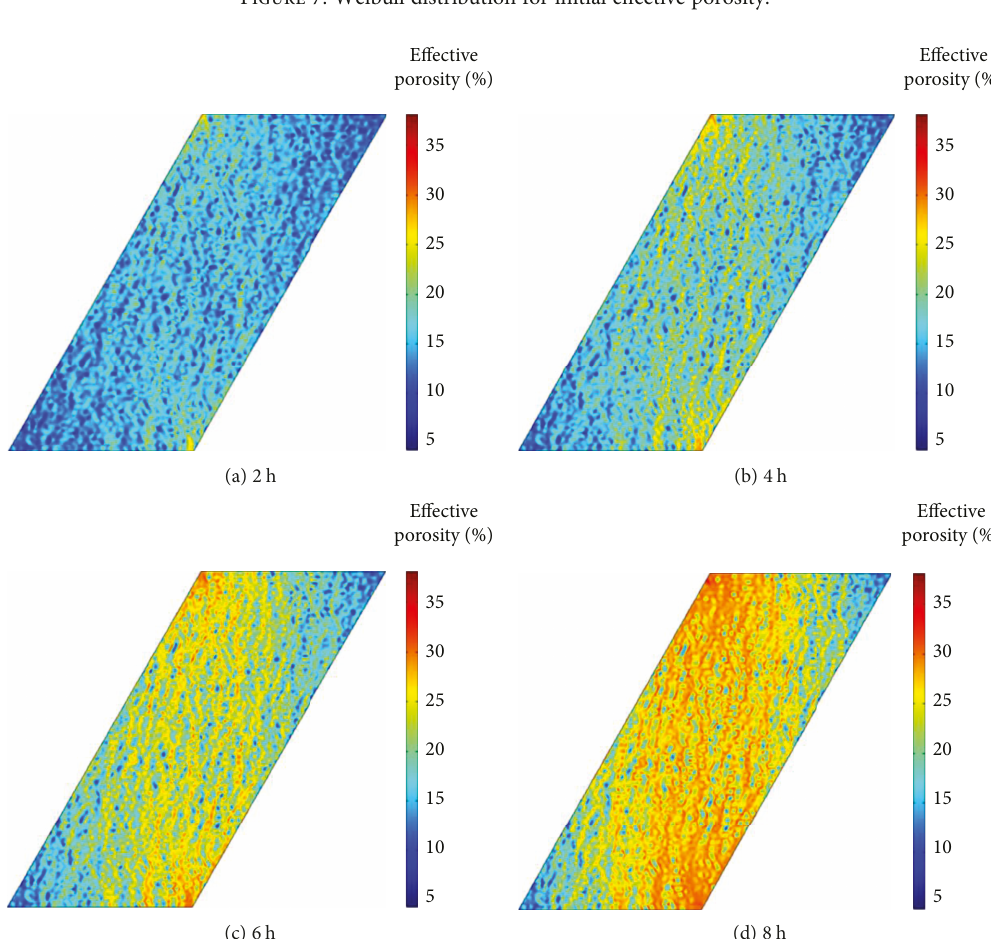
Figure 8: The spatial distribution of e ff ective porosity at di ff erent